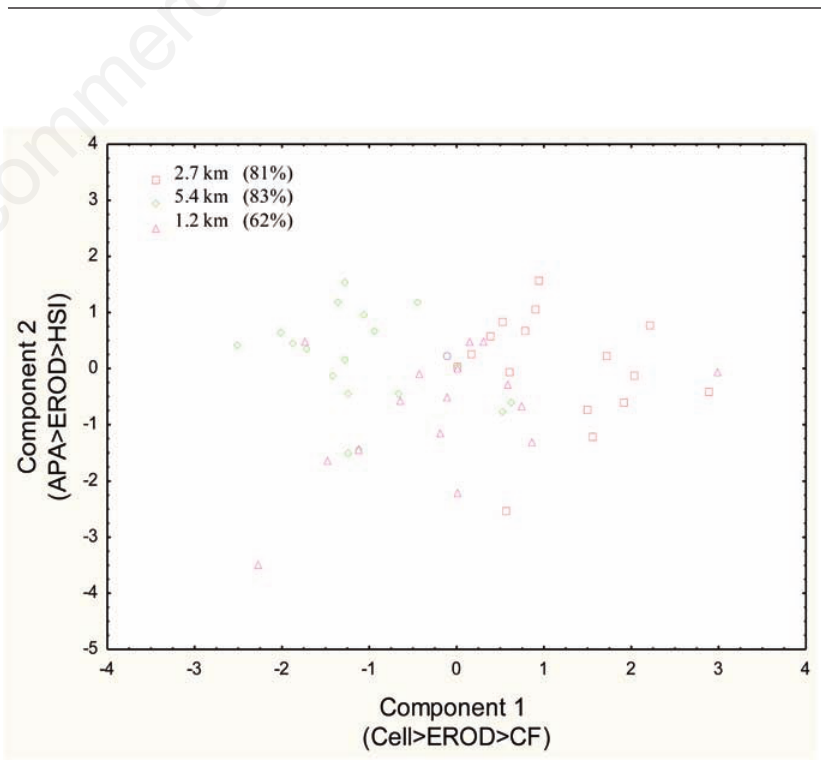
Figure 5. DNA strand break in trout liver after 4 and 14 days exposure to groundwater at 1.2 km, 2.7 km and 5.4 km. Data are presented as mean±standard error. Asterisks indi- cate significant difference from controls (**P